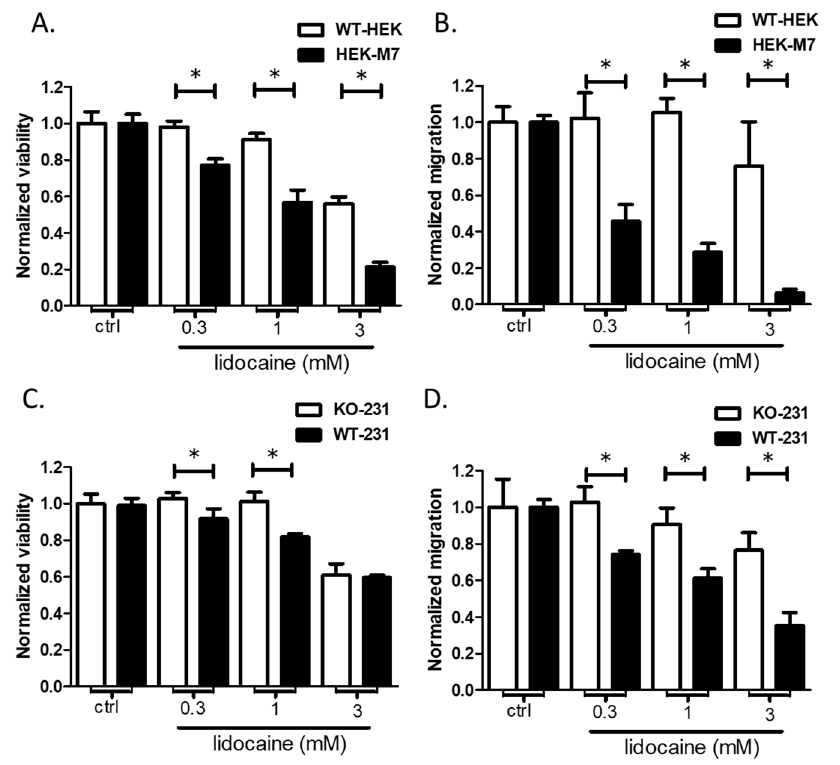
Figure 6. TRPM7 is necessary for the suppression of viability and migration by 0.3 and 1 mM lidocaine. Viability ( A ) and migration ( B ) of HEK cells containing very low levels of TRPM7 (WT- HEK) are unaffected by low concentrations of lidocaine. In contrast, viability and migration of HEK-M7 cells, in which TRPM7 is overexpressed, are suppressed. Viability ( C ) and migration ( D ) of MDA-MB-231 cells in which TRPM7 has been knocked out (KO-231) are not affected by low concentrations of lidocaine. In contrast, viability and migration of the wild-type cell line (WT-231, which express TRPM7) are suppressed. “*” indicates the significant differences ( p < 0.05).